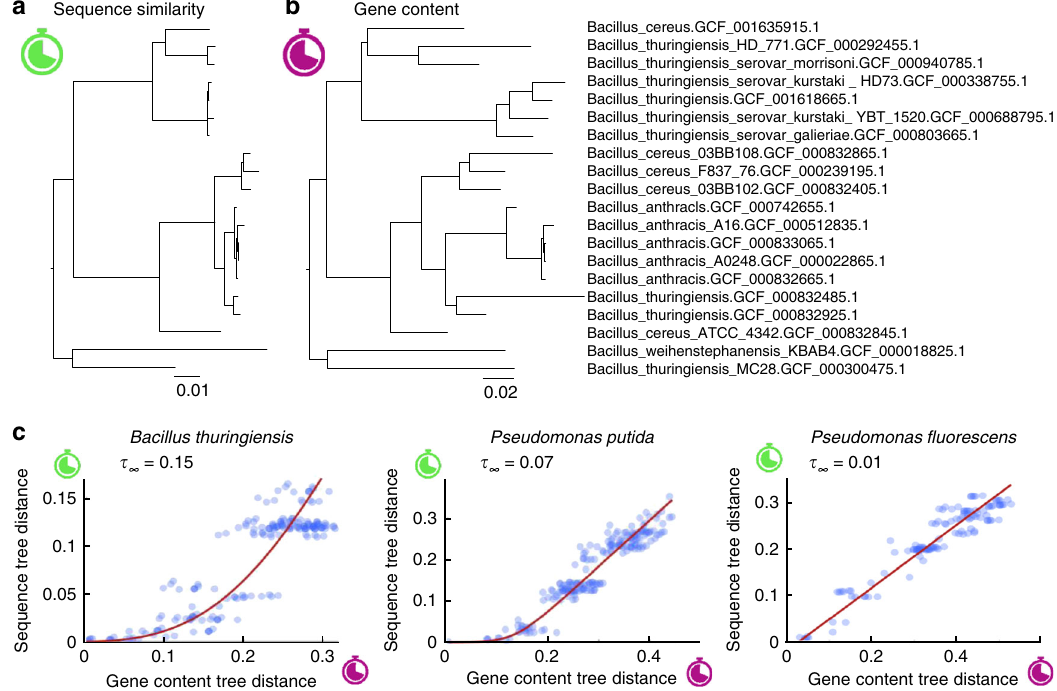
Fig. 2 Lack of collinearity between sequence and gene content distances supports a recombination-driven delay in the molecular clock. a Phylogenetic tree of the Bacillus thuringiensis / cereus / anthracis group based on the concatenated alignment of genes shared by all members of the group. b The same tree, with branch lengths proportional to the number of gene gain and loss events estimated by phylogenomic analysis. c Comparison of pairwise distances between leaves in the sequence similarity and gene content trees, for three representative groups (the left-most plot corresponds to the trees in a and b). The red line is the fi t of the recombination barrier model of sequence divergence with a long-term delay in the molecular clock equal to τ ∞ . Source data are provided as a Source Data fi sets of genomes and veri fi ed that the inferred branch lengths were proportional to the times of the simulated evolutionary process.